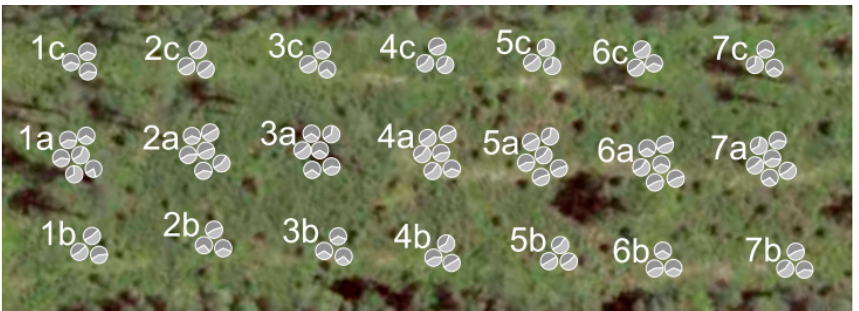
Figure 6. Spatial distribution map of sampled European aspen ( Populus tremula L.) juveniles regen- erating on a regular clearcut site (see Figure 1 for the principal sampling scheme). Pie charts show the assignment of individual juvenile MLGs to the three most likely genetic clusters, as revealed by STRUCTURE (indicated in different shades of grey).